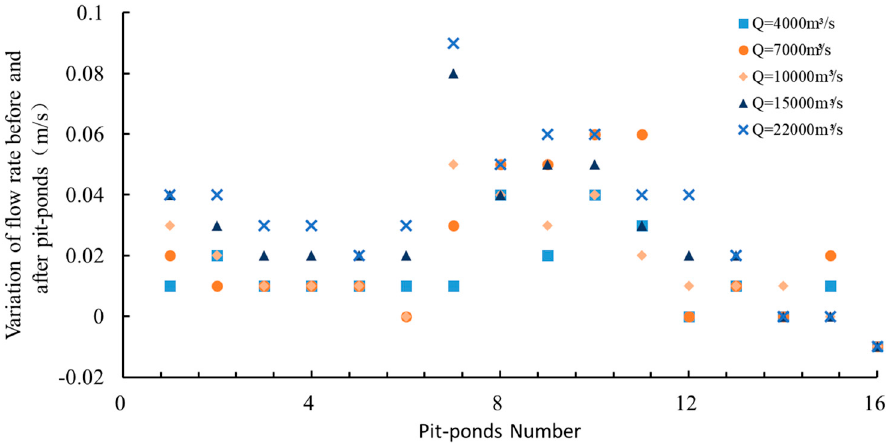
Figure 7. The variation of velocity in the pit-ponds.